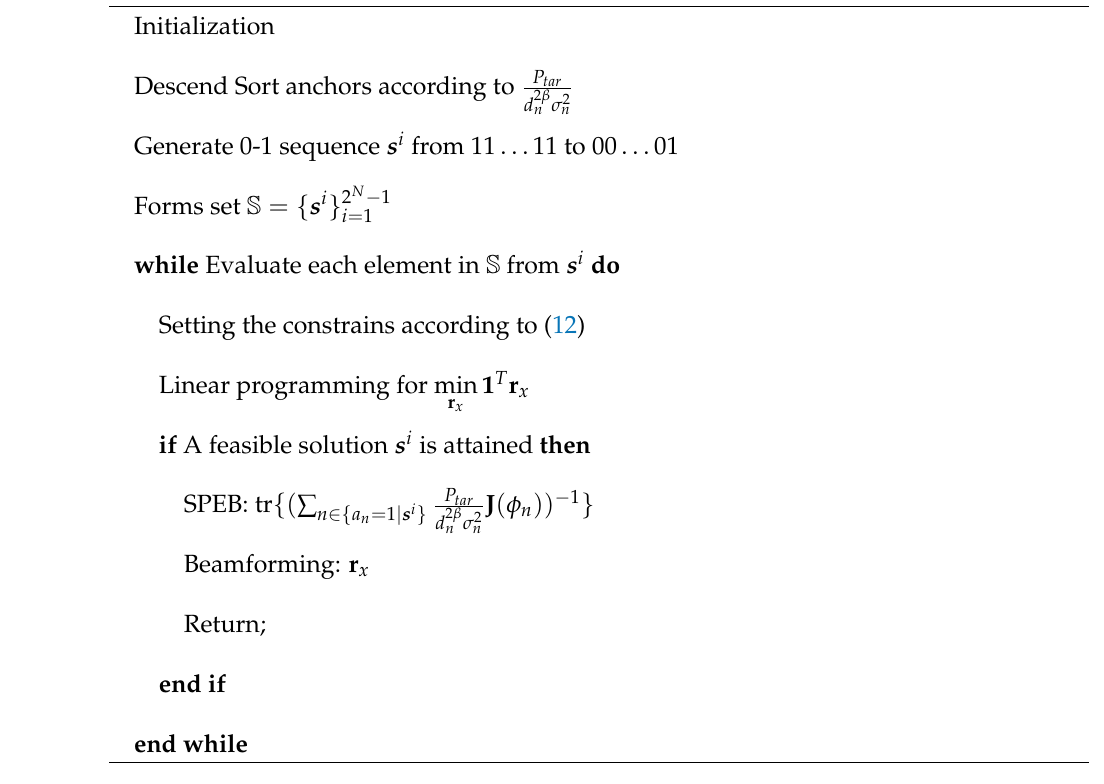
Algorithm 1 Multi-Objective Optimization